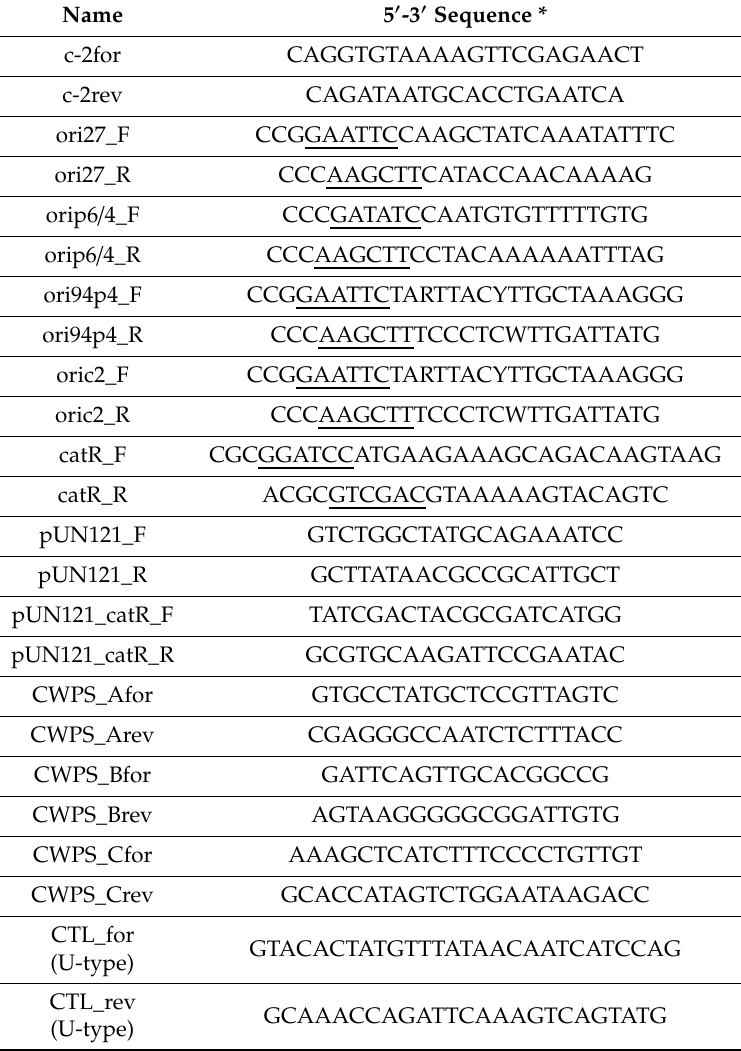
Table 2. Primers used in